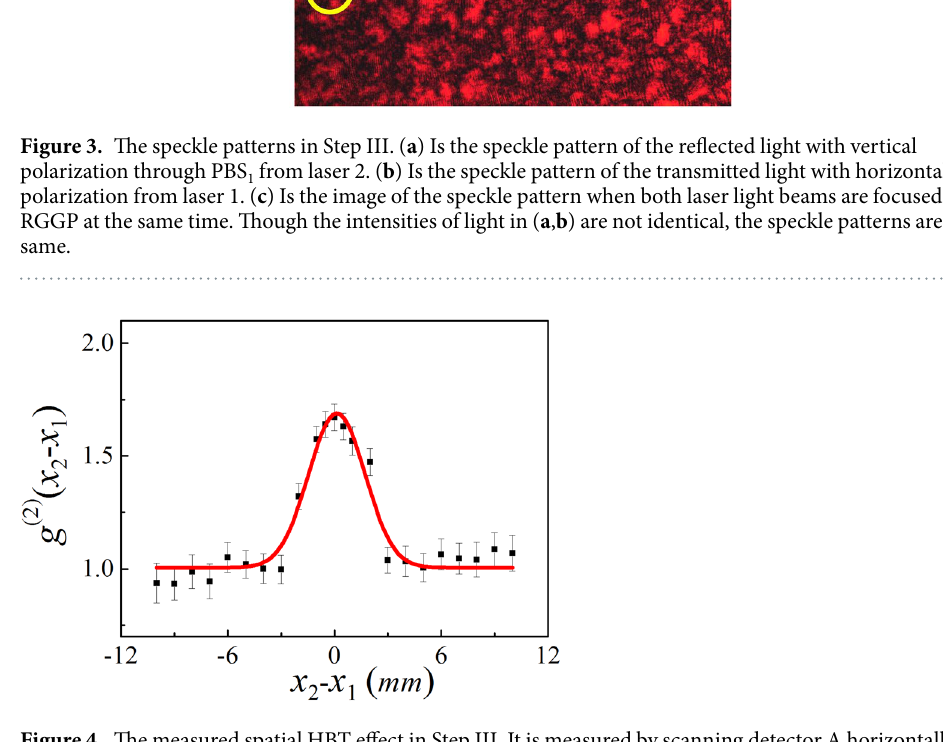
Figure 4. The measured spatial HBT effect in Step III. It is measured by scanning detector A horizontally when detector B is fixed. The FWHM is 3.75 mm and the visibility of the peak is about